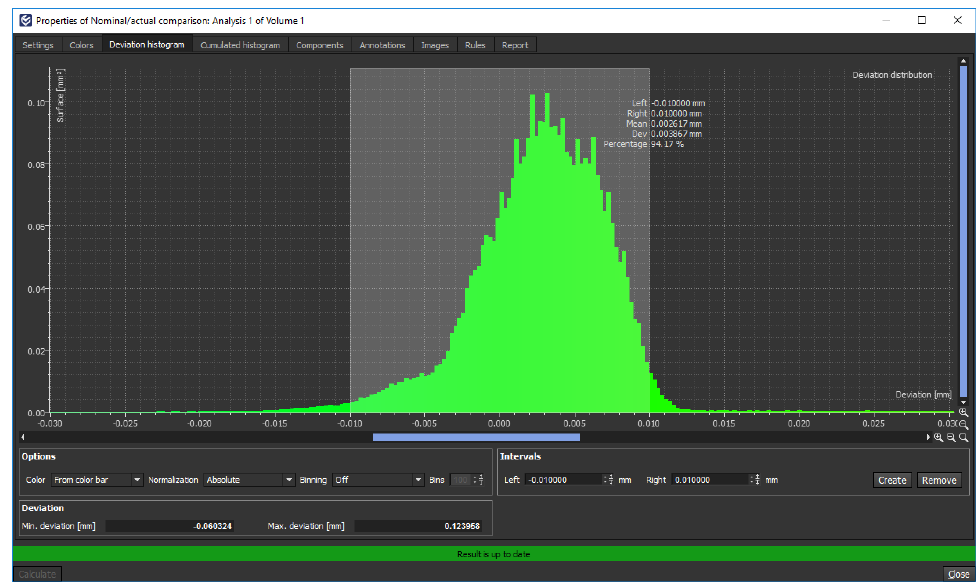
Figure 9. Deviation histogram of analyzed abstract swarf No.